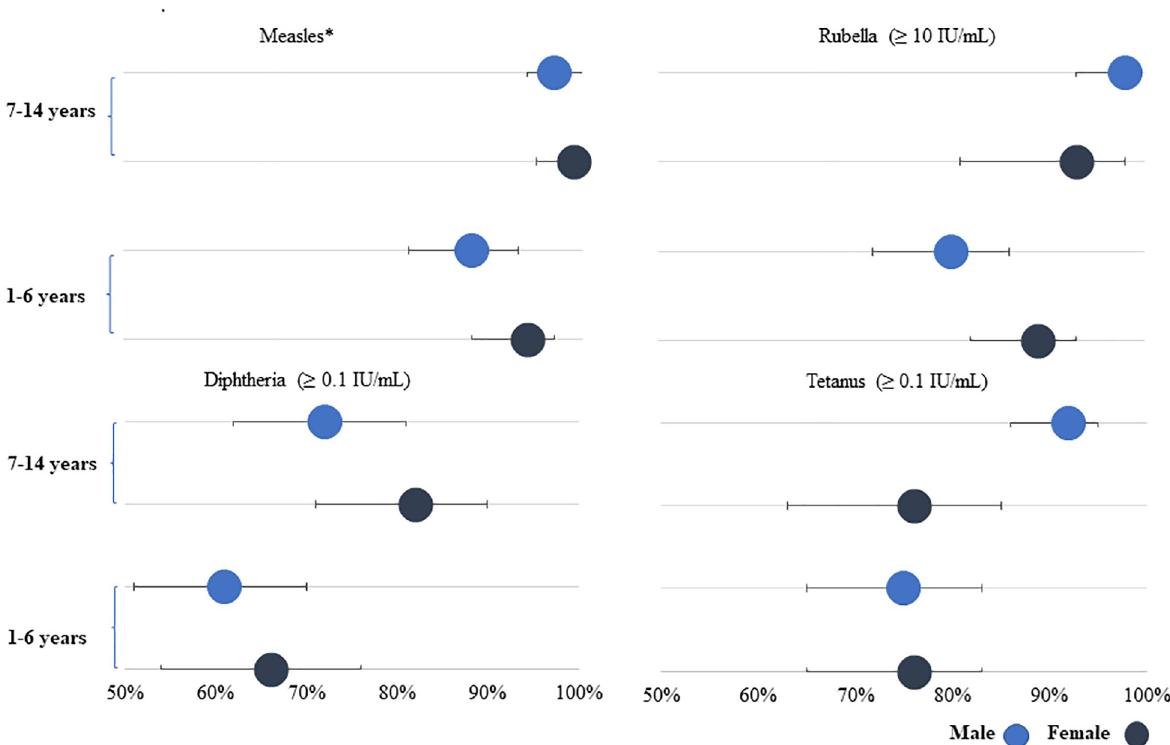
Fig 1. Percentage of children seroprotected based upon predefined antibody level cutoffs by antigen and sex, MSs, serologic and vaccination coverage survey among Rohingya children, Cox’s Bazar, Bangladesh, 2018. Children 1–6 years old: n = 358; children 7–14 years old: n = 299. � Measles virus nucleoprotein cutoff was determined empirically at the CDC, calculated by ROC with samples characterized with PRNT, where samples > 120 mIU/mL were considered positive. CDC, Centers for Disease Control and Prevention; IU, international units; MS, makeshift settlement; PRNT, plaque reduction neutralization test; ROC, receiver operating